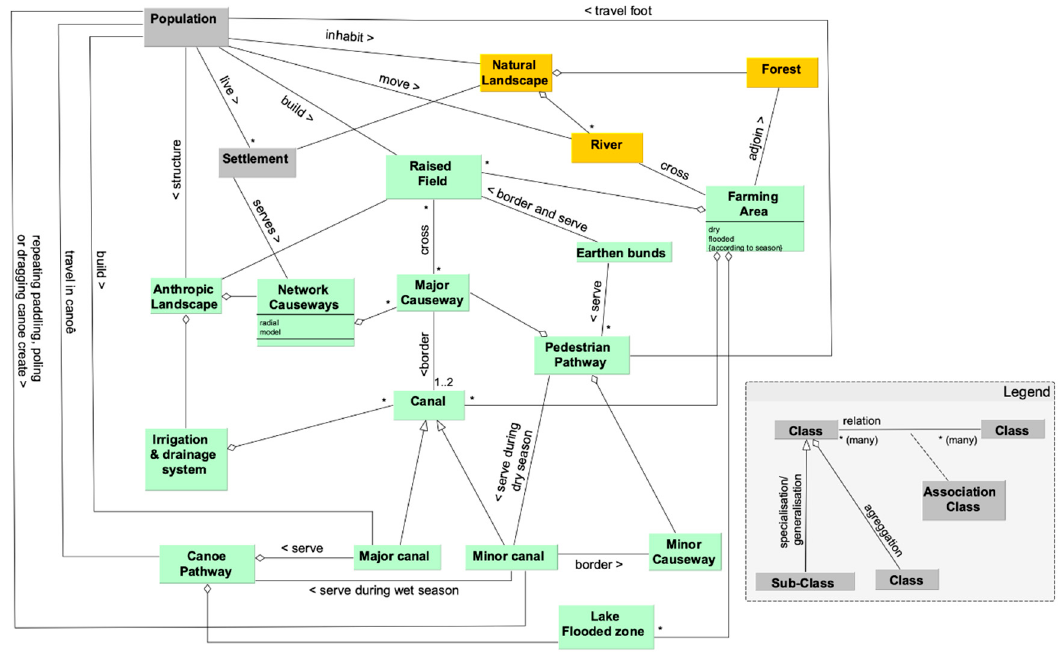
Figure 6. UML schema of a circulation system in the Bolivian Amazon.